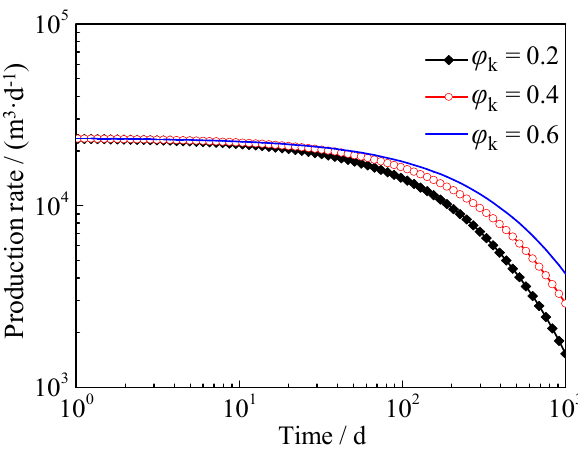
Figure 7. Influence of organic porosity on gas flow.